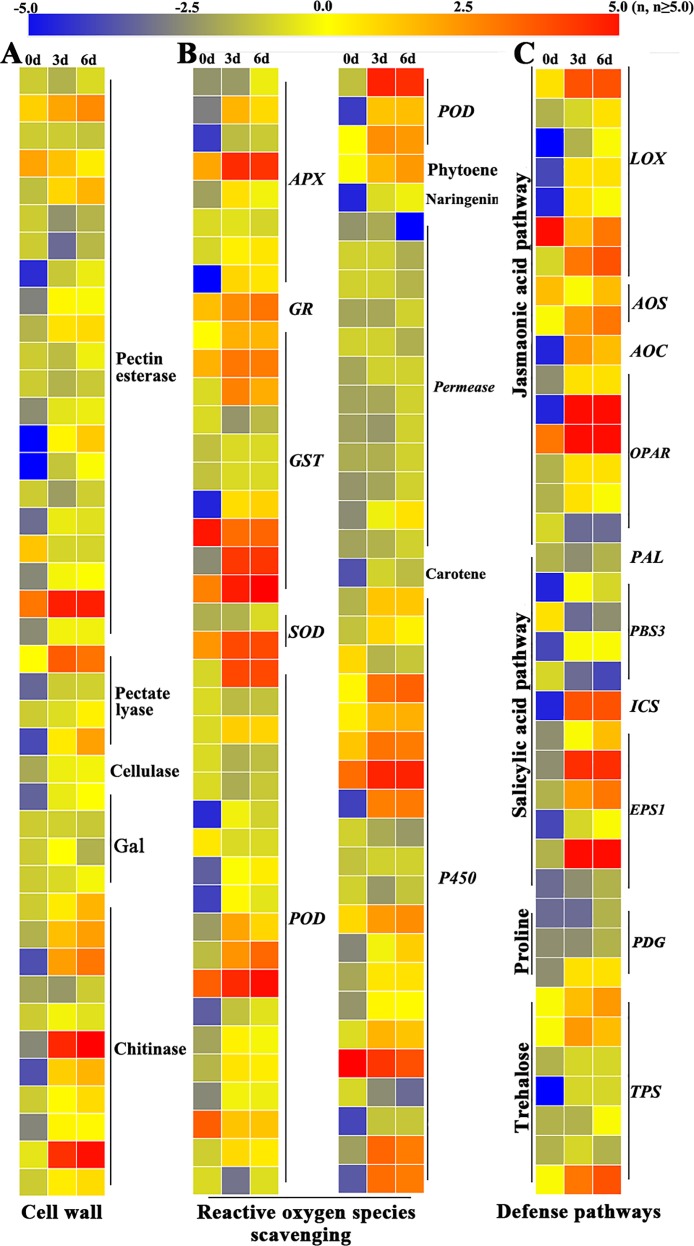
Expression profiles of genes related to defense response during dragon's blood formation in the stem of D. cambodiana.Stem samples were collected at 0, 3, and 6 days after treatment with the special inducer. Gene expression in the stems of D. cambodiana is indicated by mean-centered log2-transformed FPKM values, and blue, yellow and red bars show low to high expression levels. A: plant cell wall compounds synthesis related genes; B: reactive oxygen species (ROS) scavenging related genes; C: genes involved in plant defense pathways.